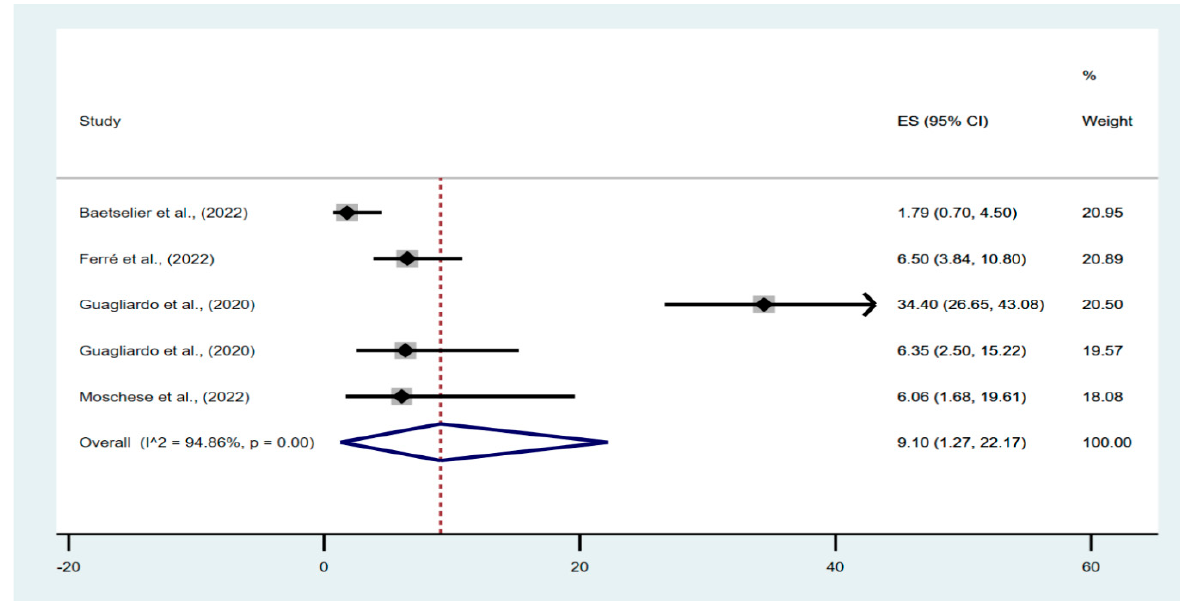
Figure 2. Pooled prevalence forest plot of asymptomatic monkeypox [11–14].